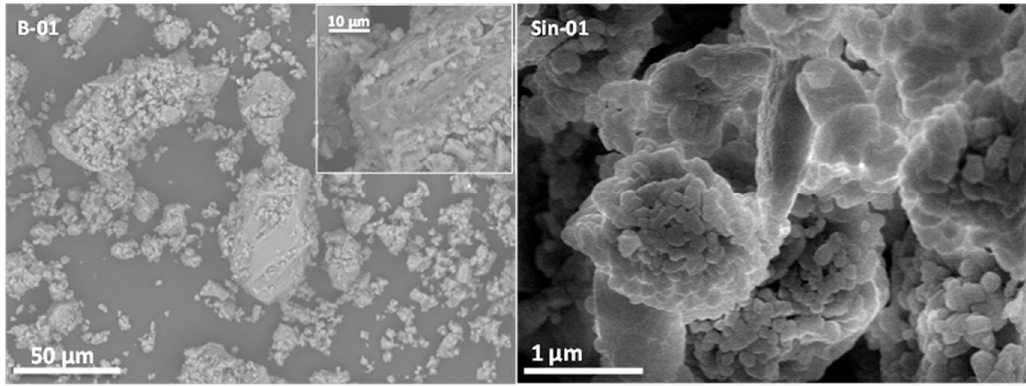
Figure 4. SEM micrographs of bentonite B-01 sample and synthetic mordenite (Sin-01).